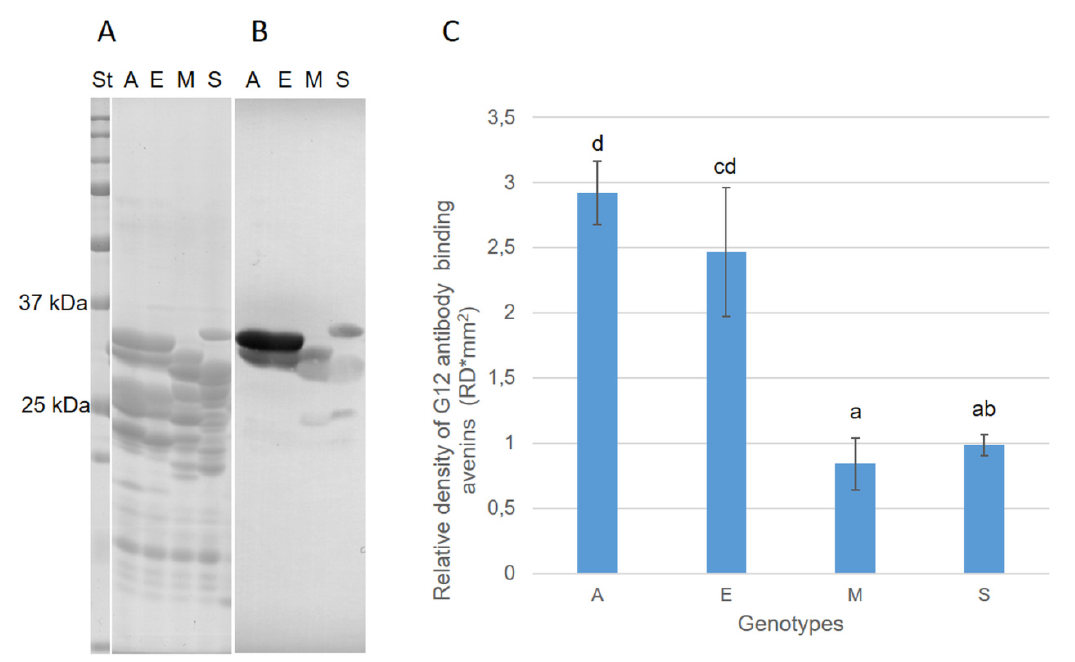
Figure 5. Immunoblotting: ( A ) Coomassie ‐ stained peptides in 12.5% SDS ‐ PAGE gel; ( B ) detection of G12 antibody ‐ reactive bands in nitrocellulose membrane; and ( C ) densitometric analysis of protein reactivity to G12 antibody. Error bars indicate SD and different letters indicate significant differences at 0.05 level using ANOVA analysis followed by Duncan’s multiple range test. A—Azur, E—Euro, M—Mojacar, S—SG ‐ K 16370, and St—All Blue Precision Plus Protein Standard (Bio ‐ Rad).